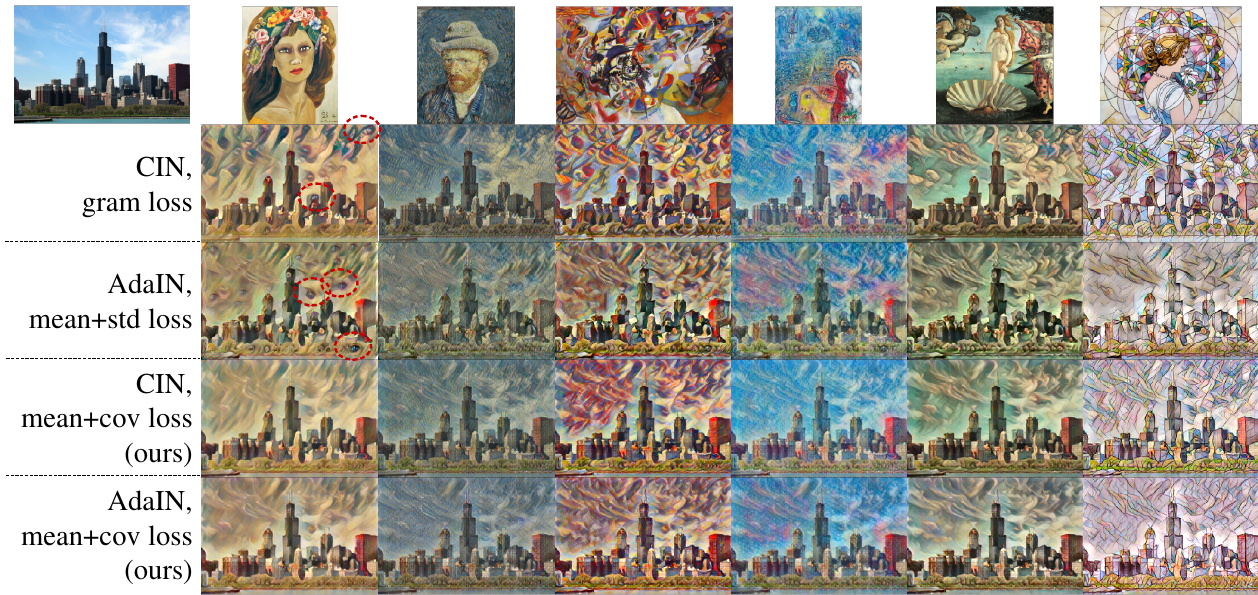
Figure 2. Style-transferred images in several seen styles with networks trained on a small style dataset. The red circles show artifacts on the output